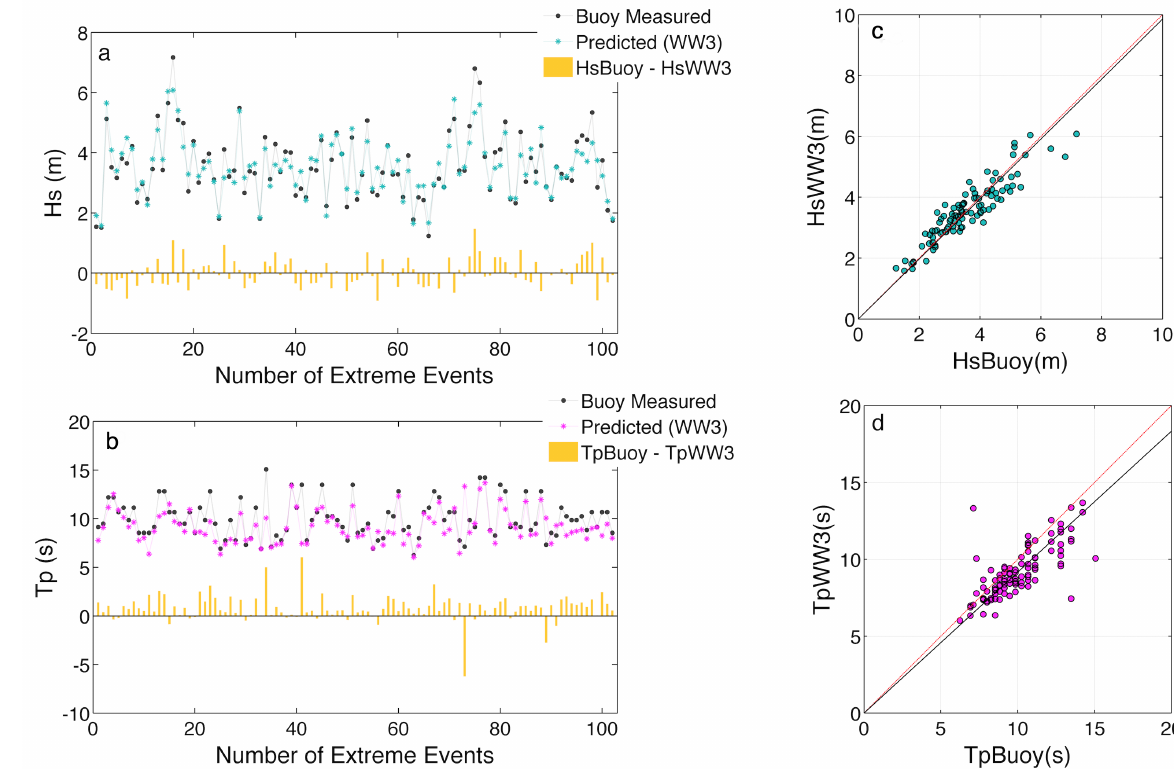
Figure 4. Model x Buoy. Figure (a) and (b) the blue/pink and black dots indicated the 102 extreme cases predicted by WW3 and measured by Minuano buoy respectively, and the yellow bars are the difference between parameters measured and predicted. In the (c) and (d) represent the scatterplot between parameters (Hs and Tp) modeled x measured for the extreme events in the analysis Model x Buoy.